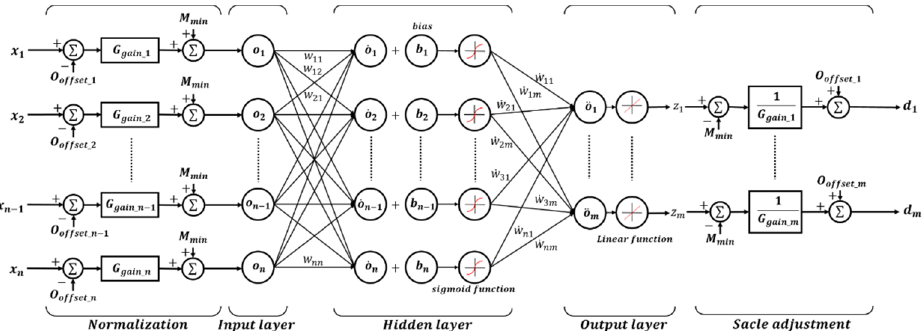
Figure 4. The structure of an artificial neural network. Both the walking speed estimation and the angle estimation of each joint are composed of neural network algorithms of the same structure.